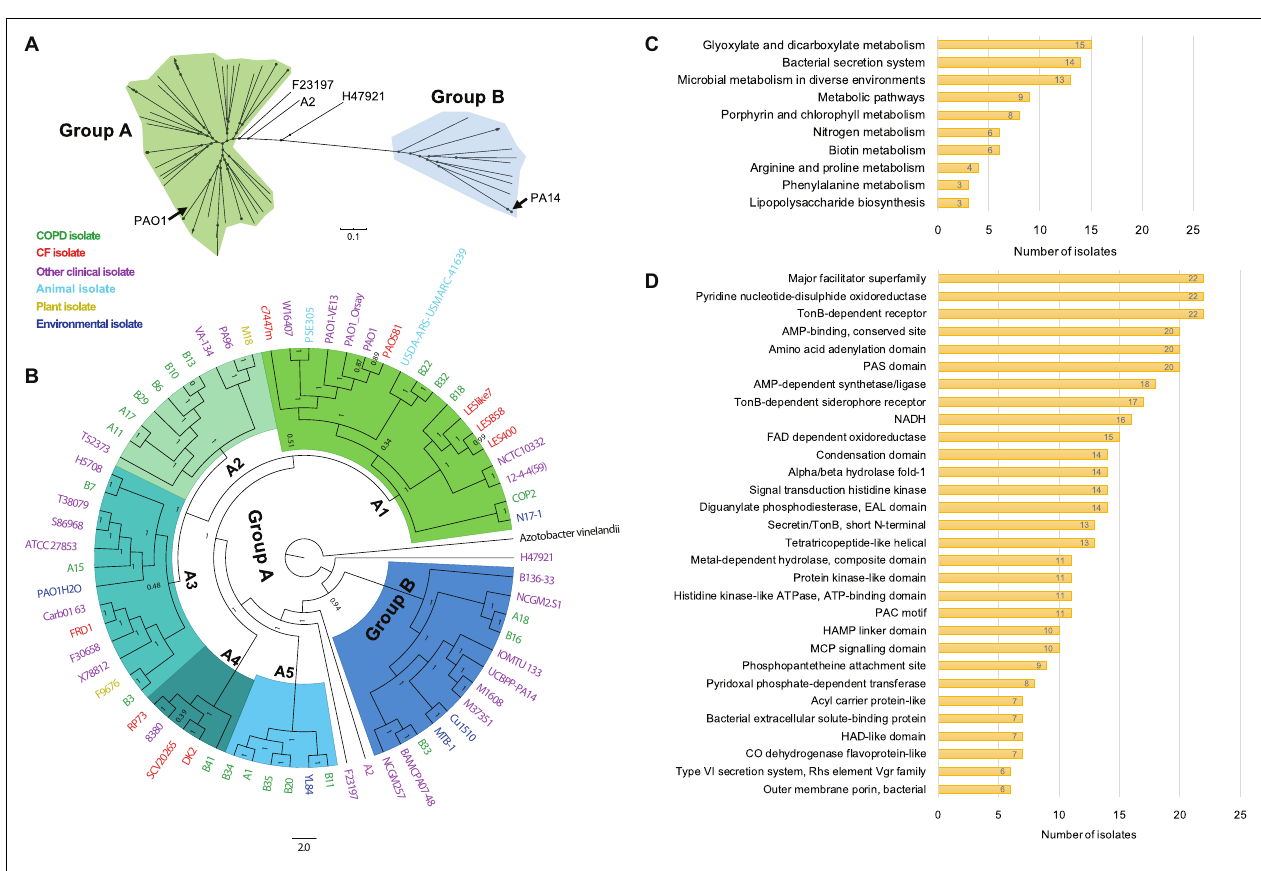
FIGURE 2 | Phylogenetic analysis and functional enrichment of genes with non-synonymous SNPs among P. aeruginosa COPD isolates. (A) Unrooted tree showing the phylogeny of all P. aeruginosa isolates tested in this study. (B) Phylogenetic tree of P. aeruginosa isolates identified in this study and other 46 internationally collected isolates constructed based on the SNPs (compared with PAO1) using maximum-likelihood method. Azotobacter vinelandii was set as outgroup. Numbers on the nodes indicate bootstrap values for branches. The names of P. aeruginosa isolates are colored according to the sources. Green, COPD isolate. Red, CF isolate. Purple, other clinical isolate. Aqua, animal isolate. Yellow, plant isolate. Mazarine blue, environmental isolate. The region of group B is colored in dodger blue, and group A is composed of the remaining five sub-groups (A1–A5). (C) Number of P. aeruginosa COPD isolates harboring the commonly enriched KEGG terms by the genes with non-synonymous SNPs ( p < 0.05). (D) Number of P. aeruginosa COPD isolates harboring the commonly enriched protein classification terms by the genes with non-synonymous SNPs ( p <